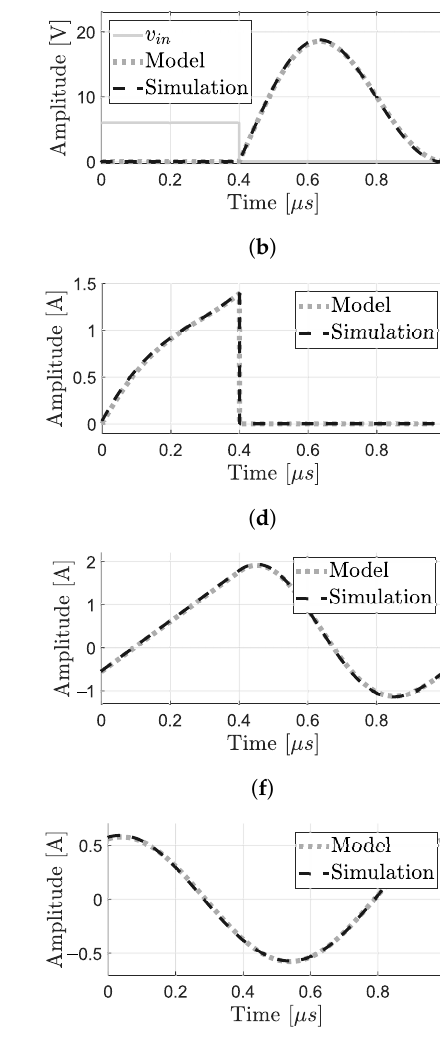
of amplifier ID 6. ( c ) i S W of ID L